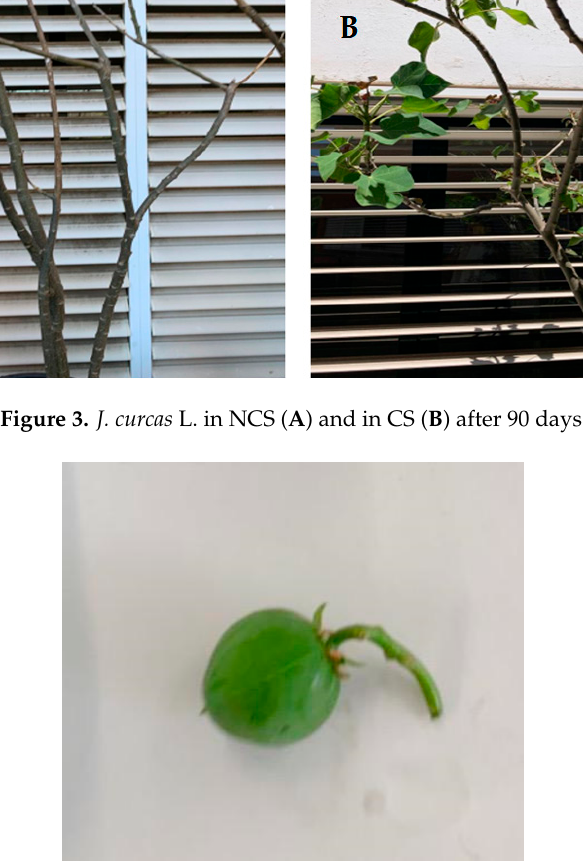
Figure 4. Seed from CS plant.